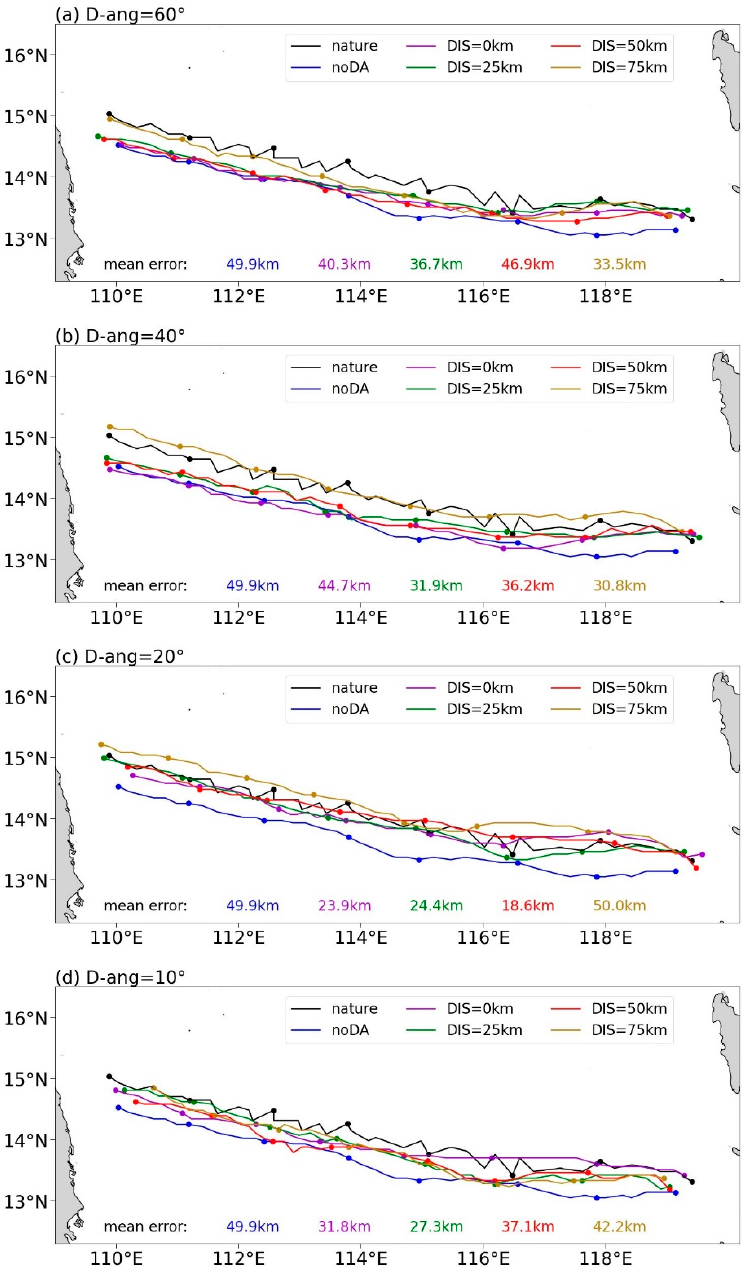
Figure 9. The track forecast of assimilating airship-borne radar observations under a D-ang of ( a ) 60 ◦ , ( b ) 40 ◦ , ( c ) 20 ◦ , and ( d ) 10 ◦ . The track forecasts under various DISs are shown in different colors. The mean track error during simulating period of each experiment is noted in the figure with the color corresponding to the track line.